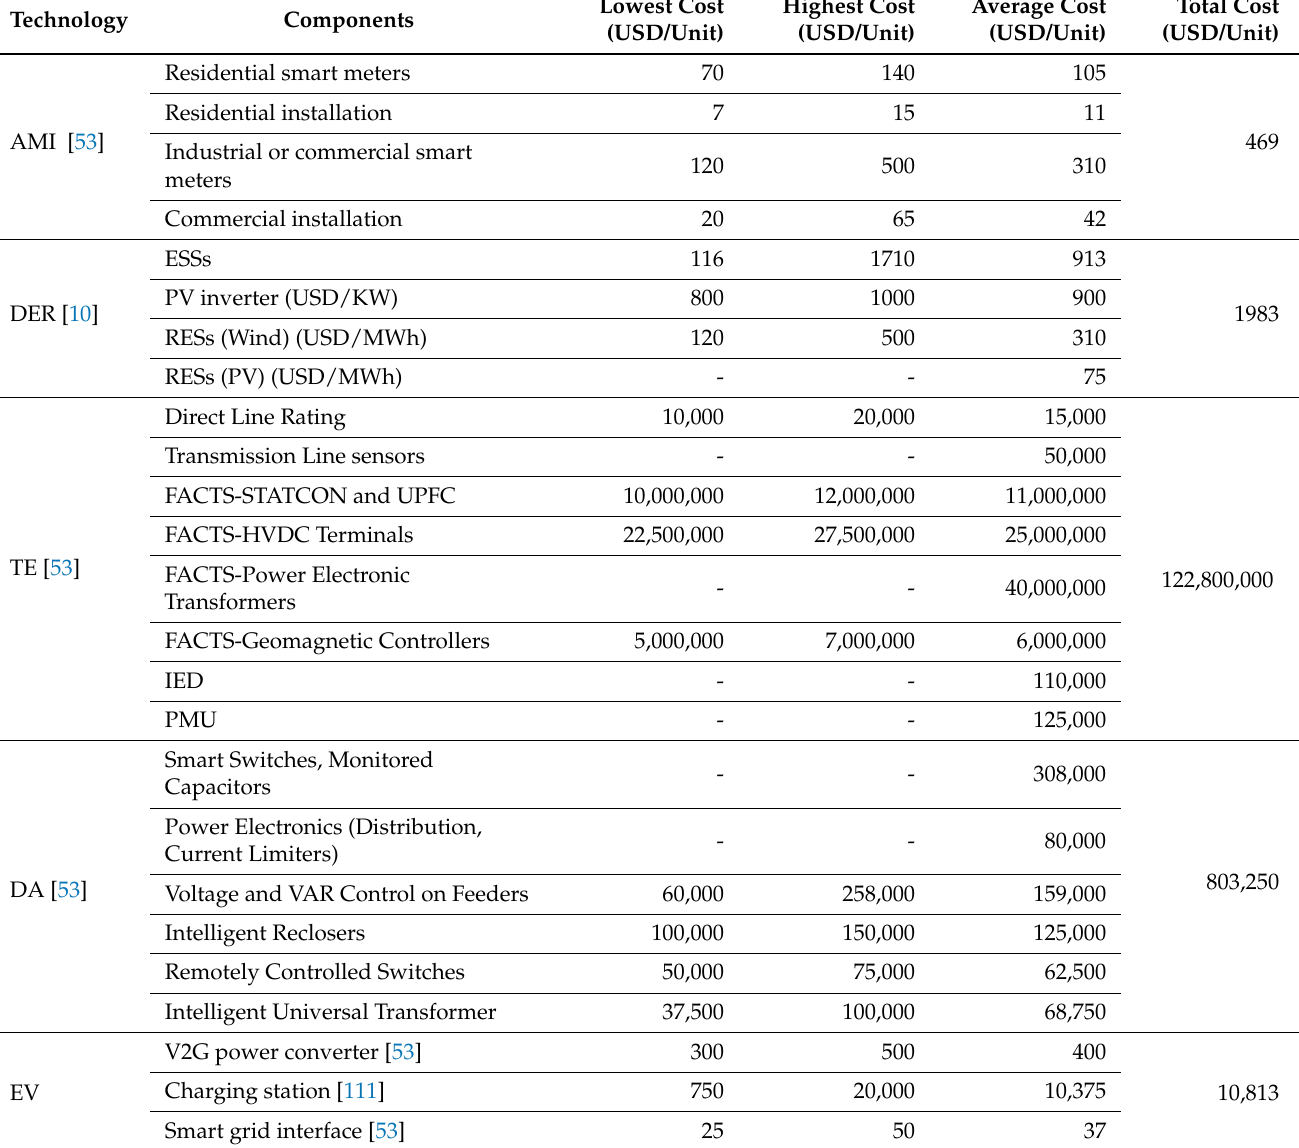
Table 17. Cost of various smart grid